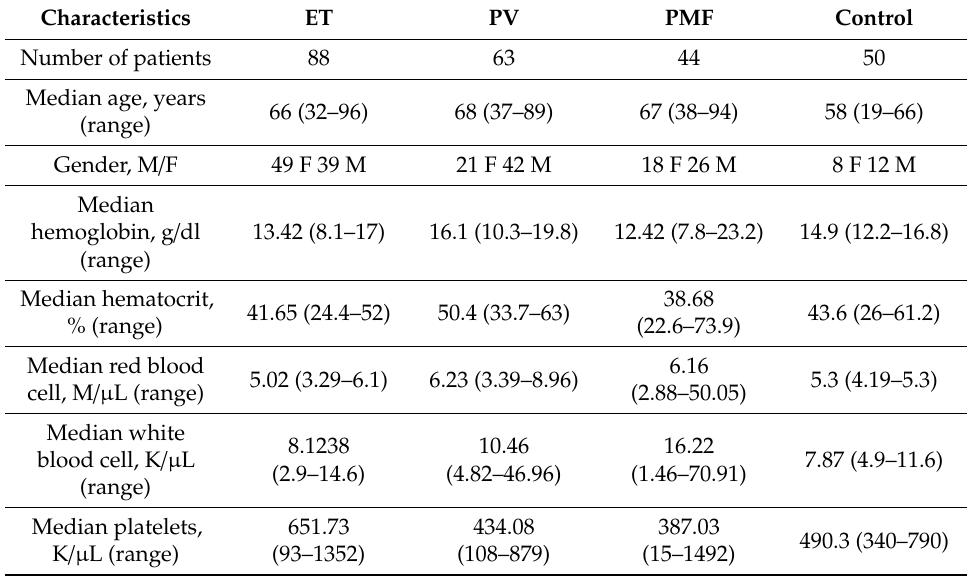
Table 1. Clinical characteristics of myeloproliferative neoplasms (MPNs) patients. PV—polycythemia vera, ET—essential thrombocytemia, PMF—primary